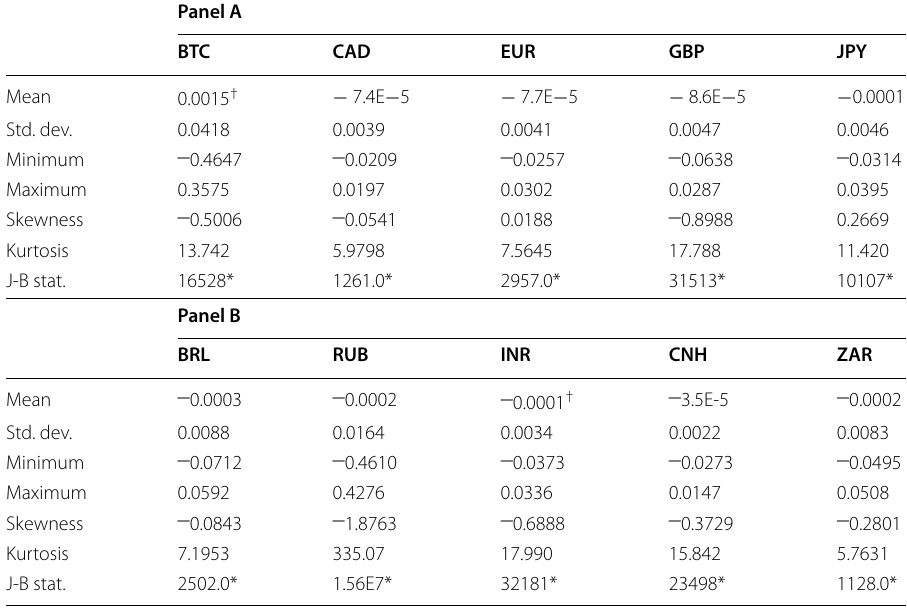
Table 2 Descriptive statistics of BTC, G7 and BRICS exchange rate